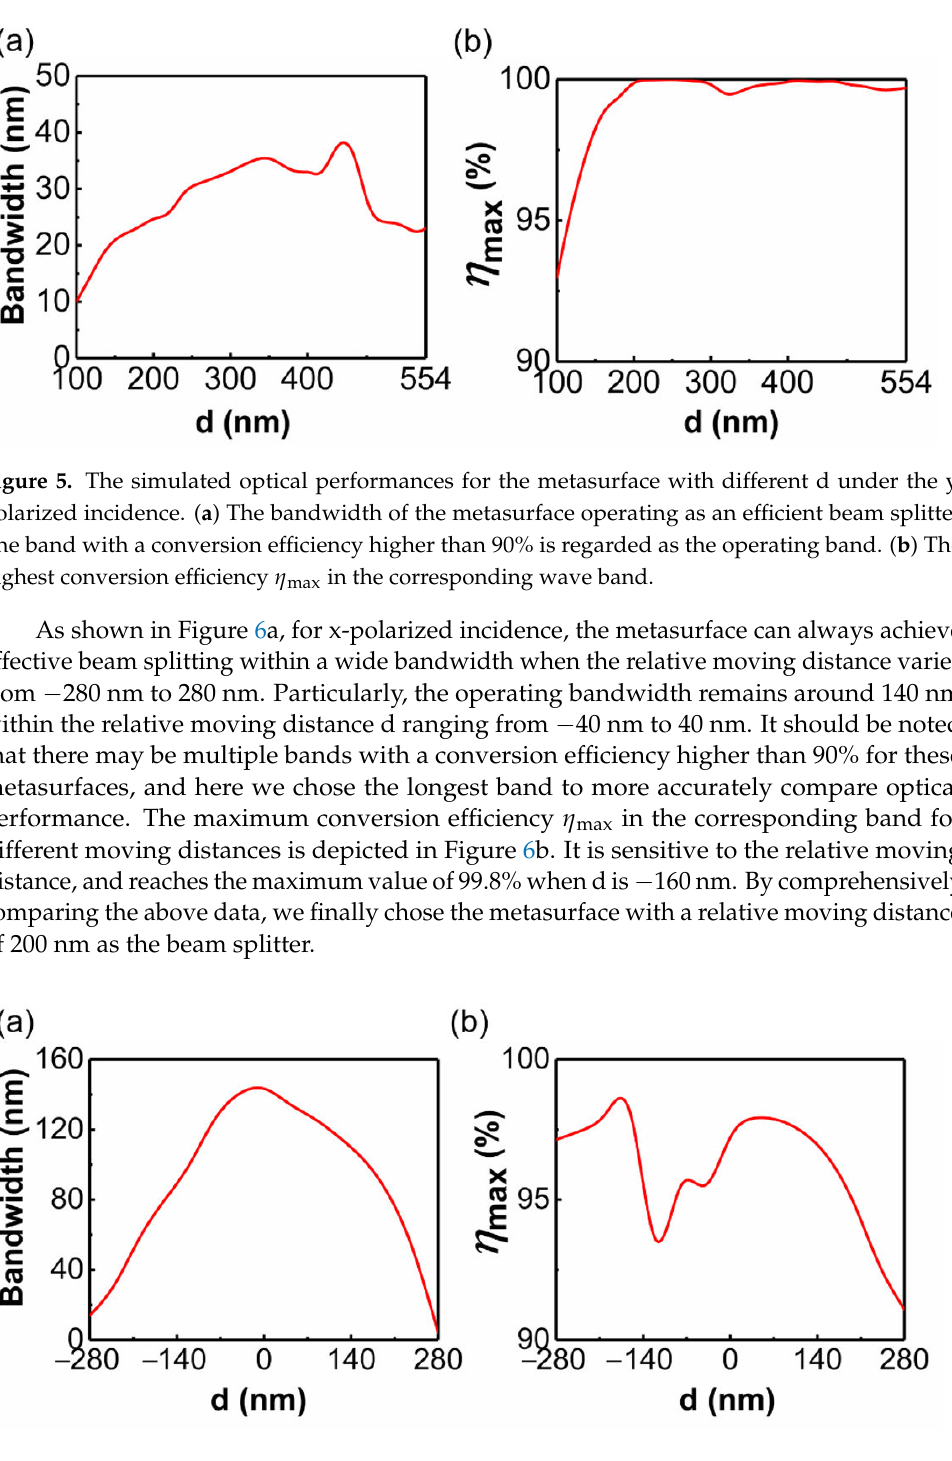
Figure 6. The simulated optical performances for the metasurface with different d under the x- polarized incidence. ( a ) The bandwidth of the metasurface operating as an efficient beam-splitter. The band with a conversion efficiency higher than 90% is regarded as the operating band. ( b ) The highest conversion efficiency η max in the corresponding wave